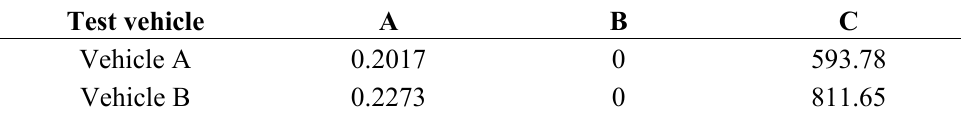
Table 5. Coastdown Coefficient results.